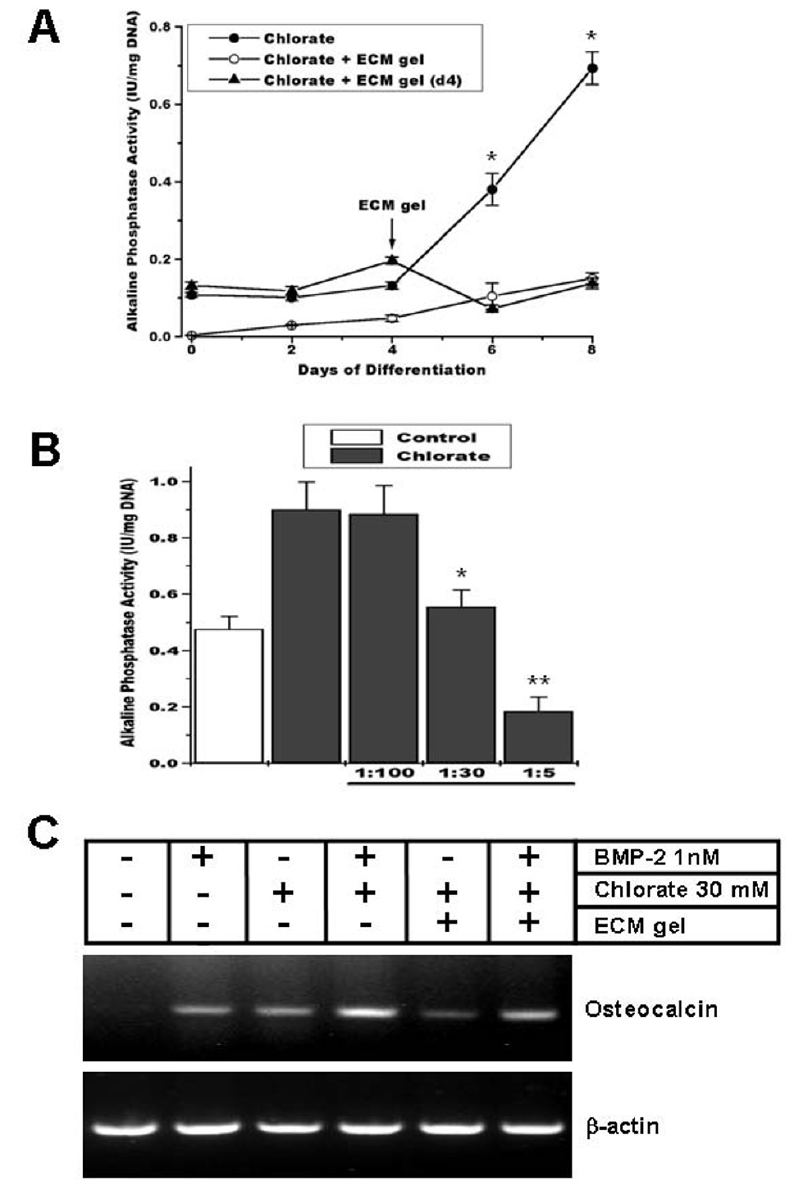
Figure 6 Addition of exogenous ECM prevents osteoblastic marker expression induced by inhibition of proteoglycan sulfation . A . C2C12 cells were induced to differentiate in the presence of 30 mM sodium chlorate (closed circles). ECM gel was added at day 0 (open circles) or at day 4 of differentiation (closed triangles). ALP activity was determined at different time points. Data are presented as mean ± S.E.M. of two independent experiments performed in triplicate (p < 0.0001, unpaired t- test between chlorate and ECM gel addition). B . ALP activity was determined in C2C12 cells induced to differentiate for 8 days in the absence (control) or presence of 30 mM sodium chlorate (chlorate) and different ECM gel dilutions were added to the cell culture. Data are presented as mean ± S.E.M. of two independent experiments performed in triplicate. * = significantly dif- ferent from chlorate without and with 1:100 ECM gel, p < 0.05; ** = significantly different from all the other conditions p < 0.05 (ANOVA followed by Tukey-Kramer multiple comparisons test between chlorate conditions). C . RNA was extracted from C2C12 cells after 6 days of differentiation in the presence or absence of 30 mM sodium chlorate, 1 nM BMP-2, and/or ECM gel. After reverse transcription using Oligo-dTs the cDNA was amplified using specific primers for osteocalcin and β -